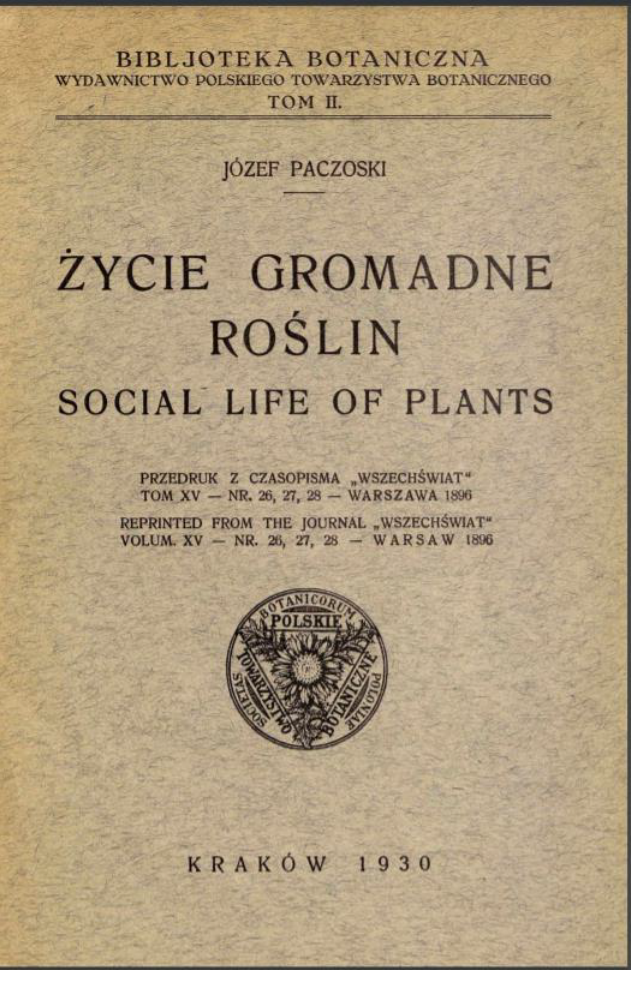
Figure 4 e reprint of the Paczoski’s work Życie gromadne roślin [Social life of plants] published originally in Wszechświat in